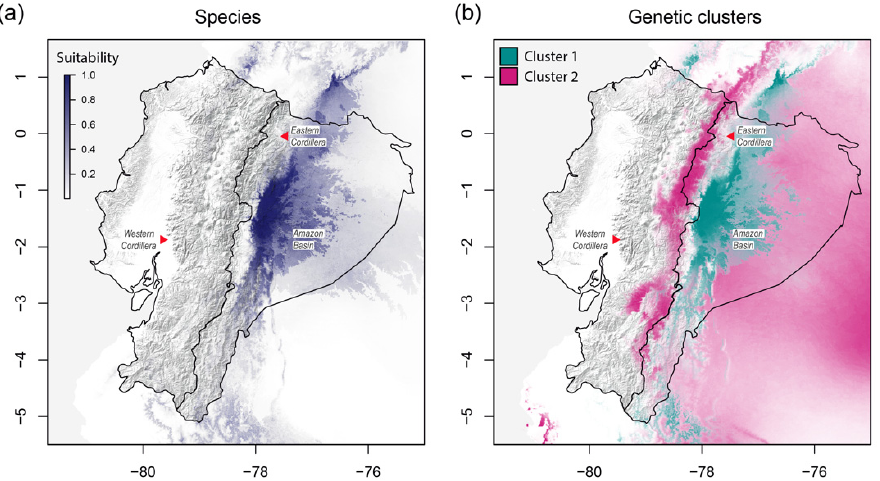
Figure 5. Modeled ecological niches for Ilex guayusa in the Ecuadorian Amazon ( a ) species level; ( b ) genetic clusters. Niche suitability, which ranges from 0 to 1, is denoted by the intensity of colors. The darker the color’s intensity, the higher the niche suitability. Table 5. Percent contribution of each bioclimatic variable to the fit of the ecological niches modeled for Ilex guayusa at the species level and for each of its genetic clusters. The two highest contributing variables for each model are highlighted in